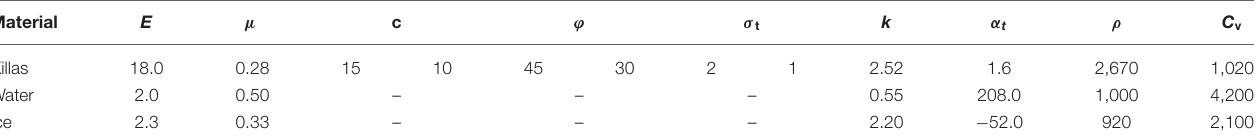
TABLE 3 | Model mechanical and thermal parameters.